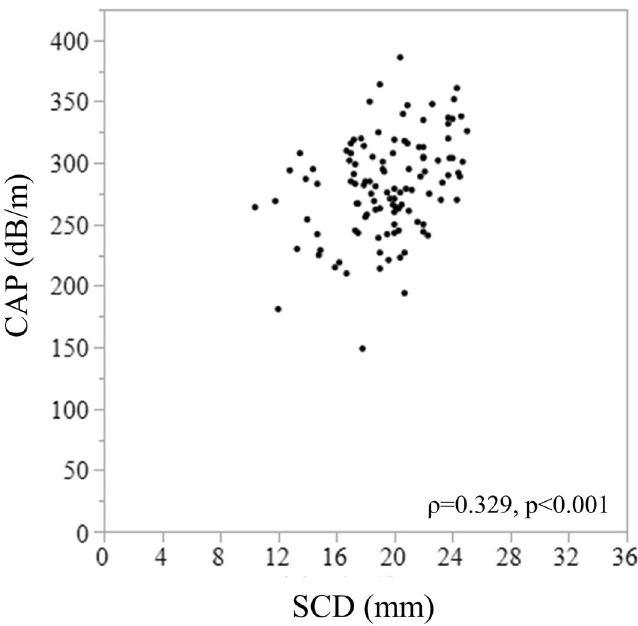
Figure 1. Correlation between CAP and SCD. CAP, controlled attenuation parameter; SCD, skin–capsular distance. Shaded error band represents 95% confidence interval.